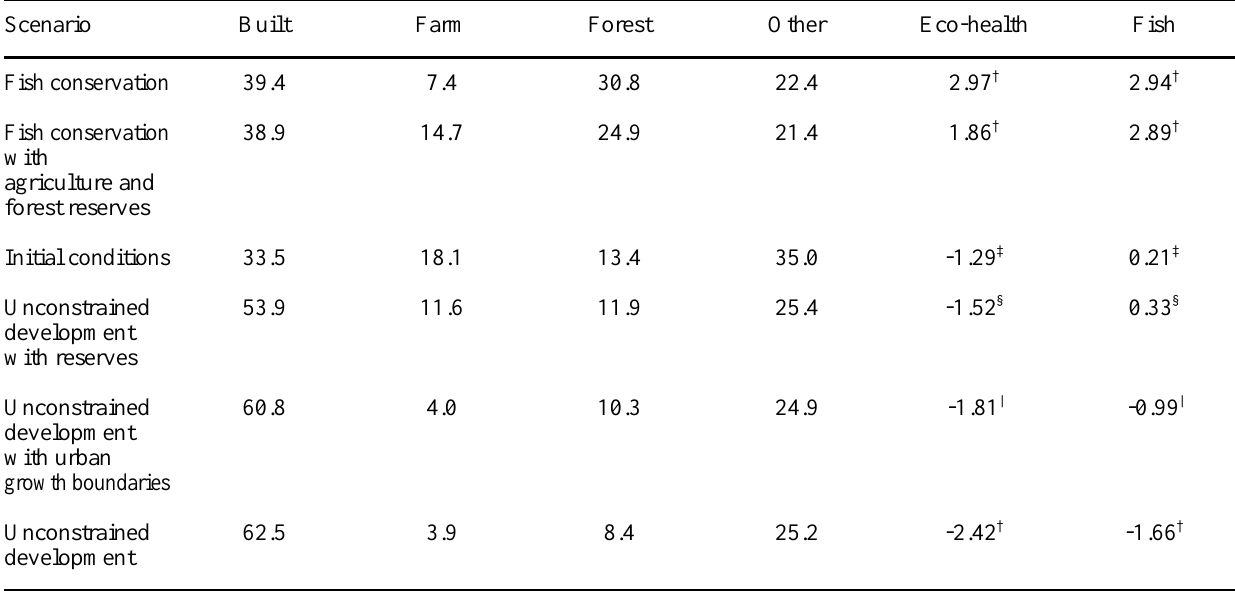
Table 3 . Scenarios to protect agriculture add an agricultural and forest reserve policy to the fish conservation and unconstrained development scenarios. Results for the fish conservation and unconstrained development scenarios from table 1 are included for comparison. Reported scores are averages of multiple runs. Scenario Built